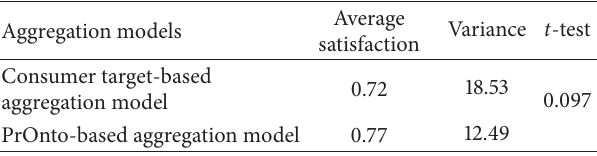
Table 3: Comparison of different aggregation models. Table 4: Comparison of different ranking methods (2).